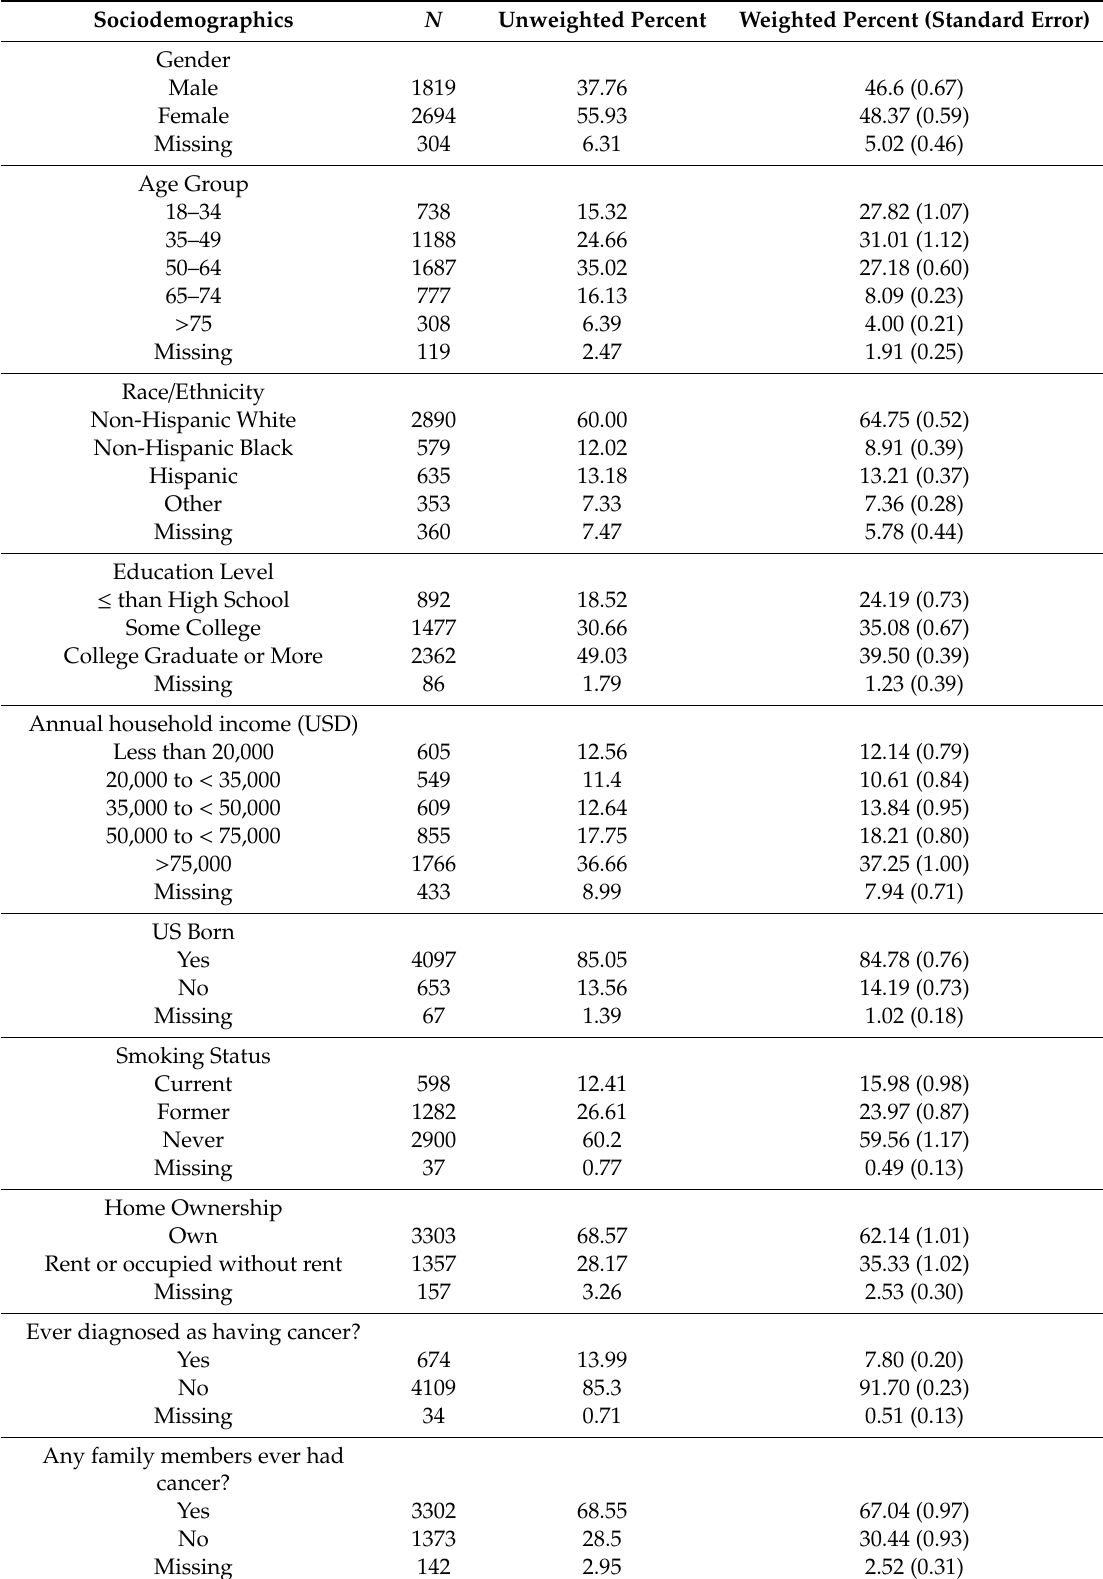
Table 1. Sociodemographic characteristics of Health Information National Trends (HINTS) participants ( N =